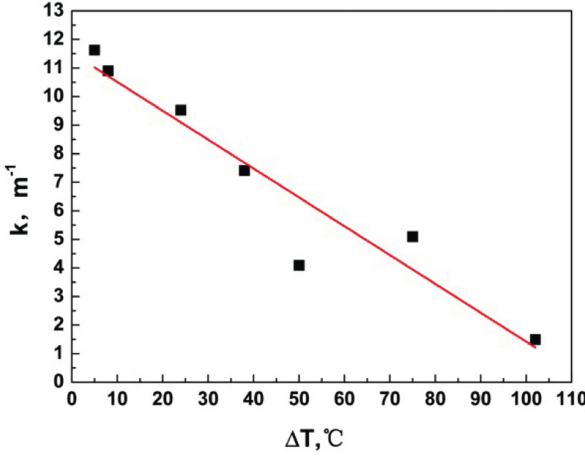
Figure 6: Effect of superheat on the bottom curvature of solidified shell of 35CrMo steel